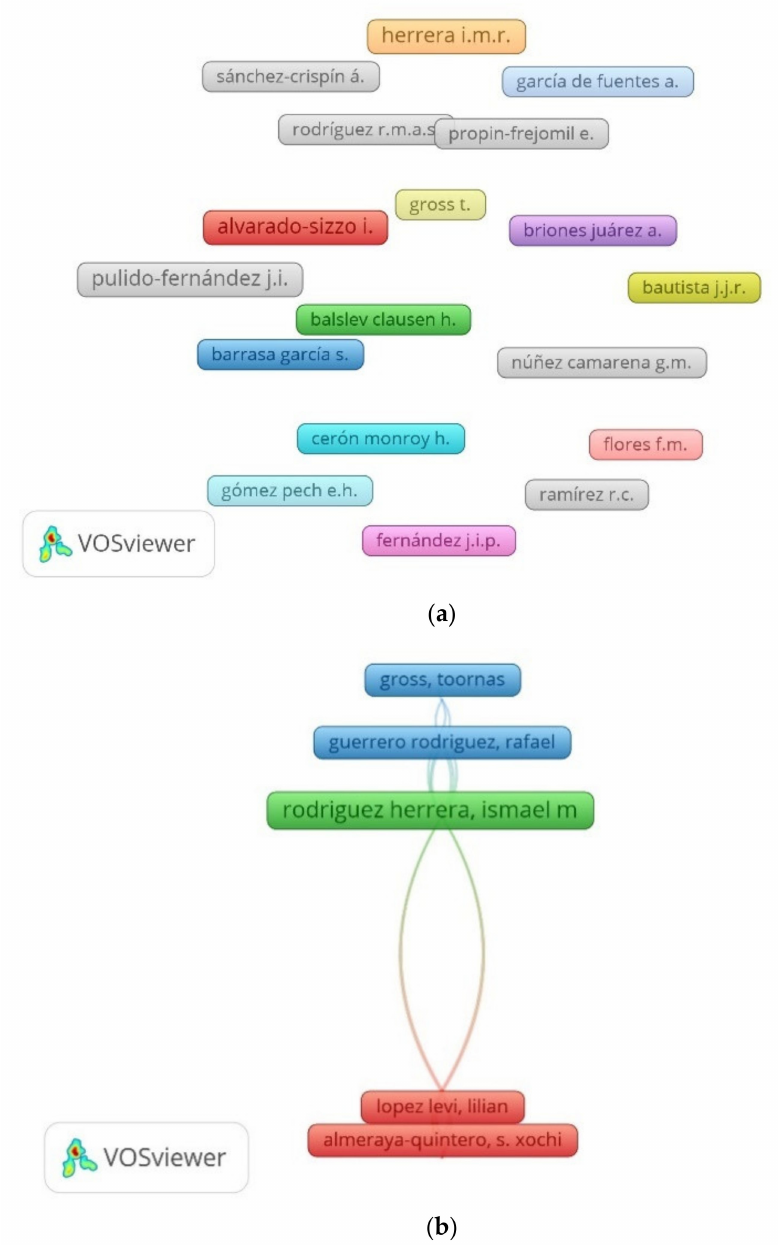
Figure 8. Network of citations between authors in the five last years, ( a ) Scopus, ( b ) WoS. Source: Own